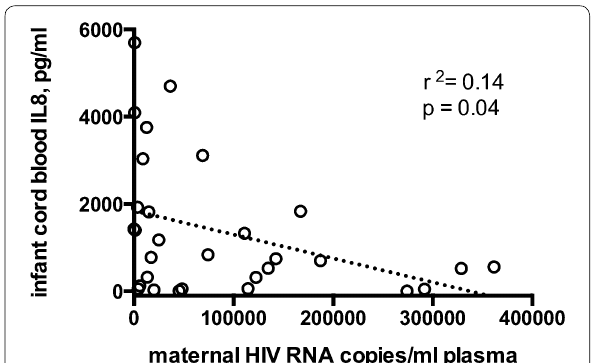
Fig. 4 Linear regression of HEU infant cord blood IL‑8 levels by maternal HIV at delivery. The impact of maternal HIV RNA copies/ ml plasma on HEU plasma IL‑8 concentrations was determined using linear regression. HIV RNA copies were determined using TMA method; IL‑8 levels were determined using multiplexed ELISA format, both as described in methods. A negative linear association between maternal viral load and infant IL‑8 concentrations at birth is shown by the dashed line, slope = −